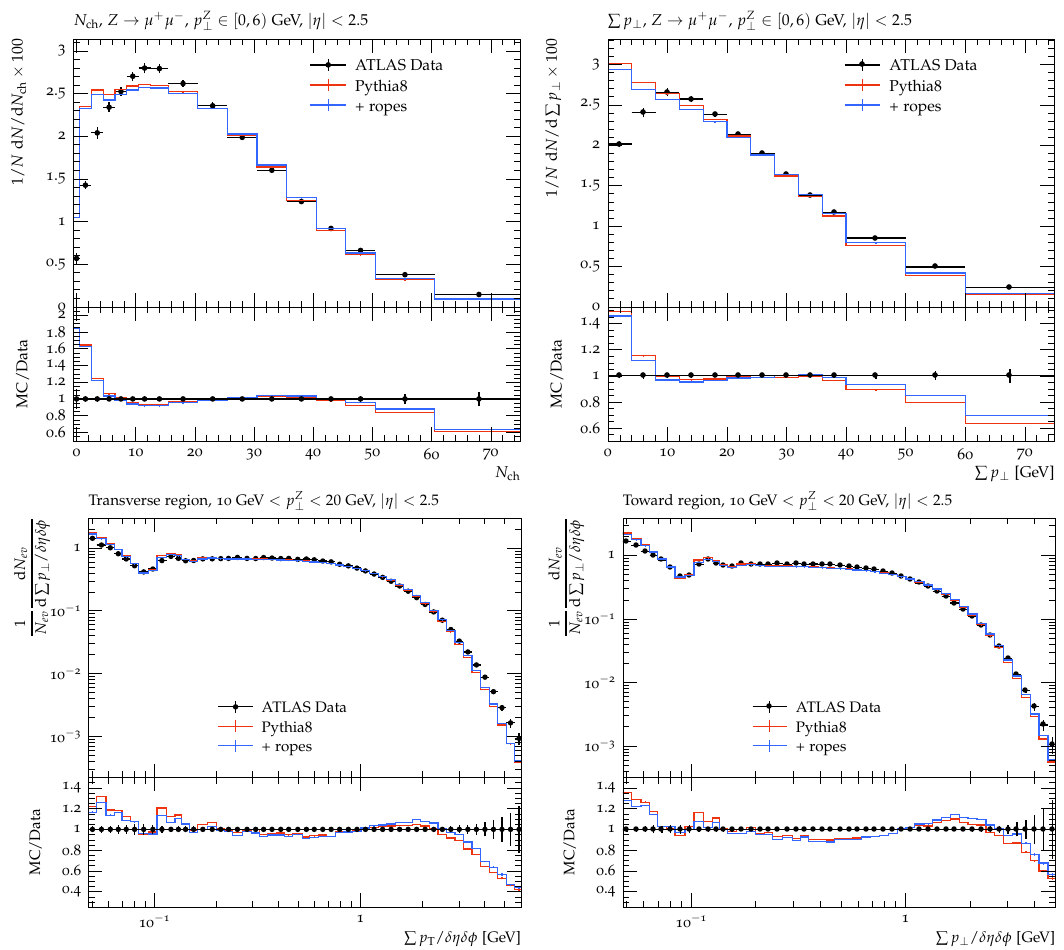
(cid:112) s = 7 TeV compared , (top left) and summed scalar transverse momenta, ch Z range 0-6 GeV [ 52 ] . Bottom row: Σ p ⊥ ⊥ range 10-20 GeV [ 53 ] . ⊥ | < 2 π/ 3, right: towards region | ∆ φ | < π/ 3. Z Z /κ 〉 vs p κ drops to lower ⊥ ,prim. plot, it is seen that eff eff